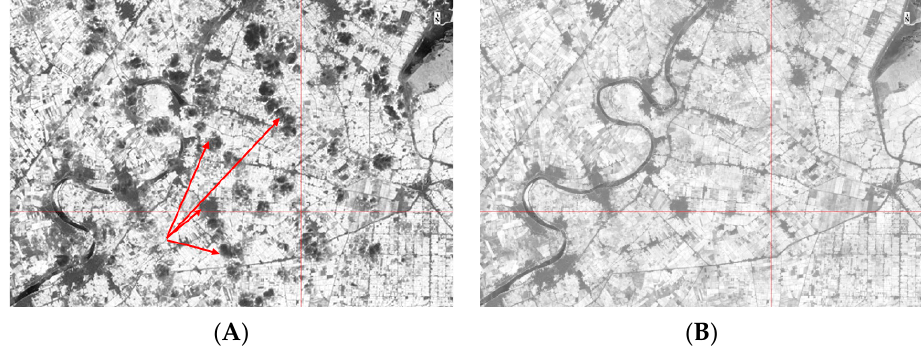
Figure 9. ( A ). Clouds before time series processing. ( B ). Clouds after time series processing.